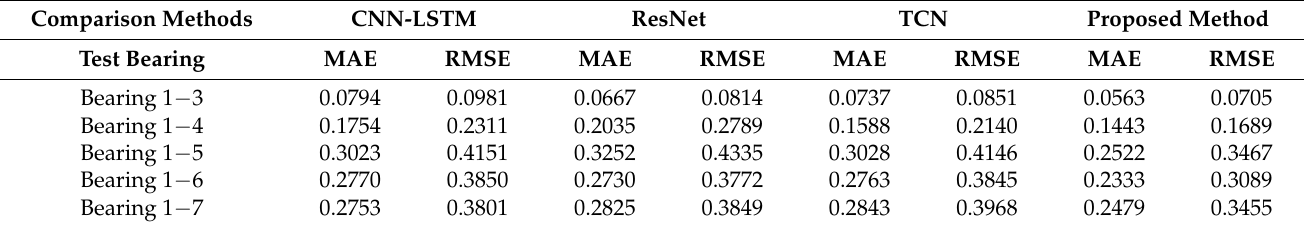
Table 3. RUL prediction results of different